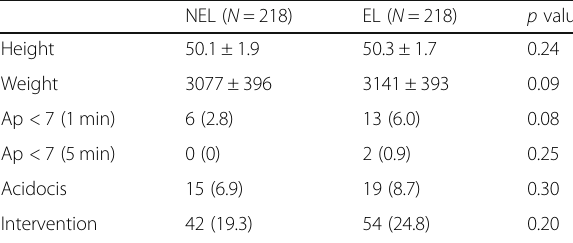
Table 3 Immediate outcome of the